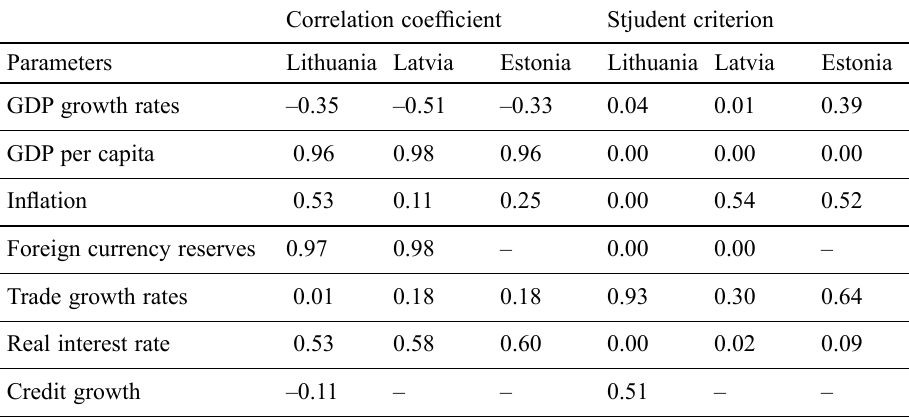
Table 6. The values of the correlation coef (cid:191) cient for the sizes of deposits in the Baltic States and the macroeconomic factors and the values of the Student’s test Correlation coef (cid:191) cient Stjudent criterion Parameters